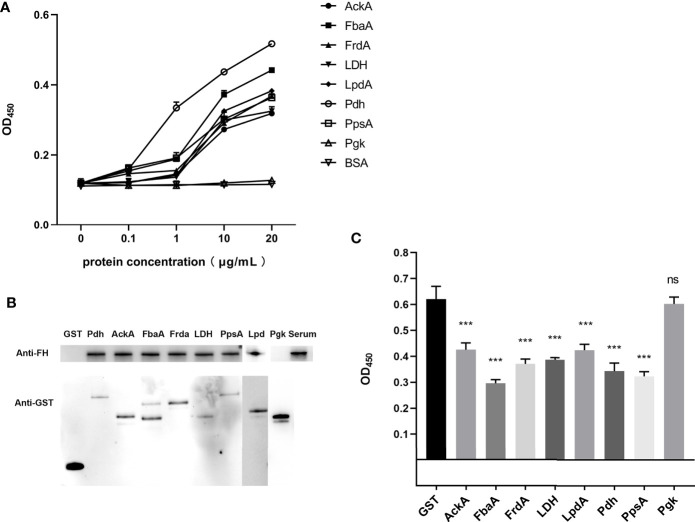
Identification of the FH-binding ability of CMEs in ExPEC. (A) ELISA plates were coated with the indicated concentrations of His-tag recombinant proteins or BSA, and then incubated with human serum. The bound FH was detected. Data are expressed as the mean ± SD of three independent experiments. The statistical significance was determined using the unpaired t test (***p < 0.001). (B) GST pull-down assay was carried out to confirm the interaction between FH and CMEs. The upper part of the panel B shows the FH-binding ability of the GST-fusion protein, and the lower part of panel B shows the results of the detection of the GST-fusion proteins. (C) FH binding inhibition assay of magnetic beads coupled with recombinant proteins. Magnetic beads coupled with GST-fusion proteins or GST protein were co-incubated with ExPEC in 10% human serum solution. The ExPEC FH-binding levels were detected by ELISA. The statistical significance was determined using the unpaired t test (***p < 0.001). Data are expressed as the mean ± SEM of three independent experiments.